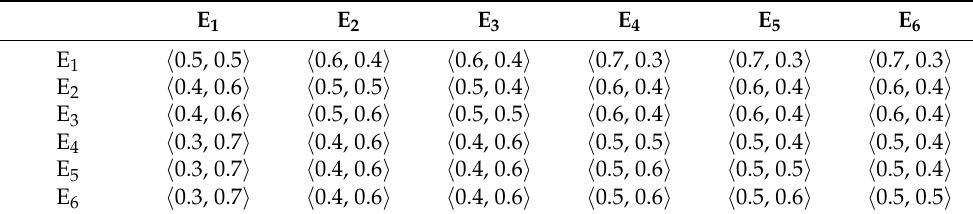
Table 5. Aggregated decision matrix in PF–AHP for the sub-criteria E ( CI = 0.0116255, CR =